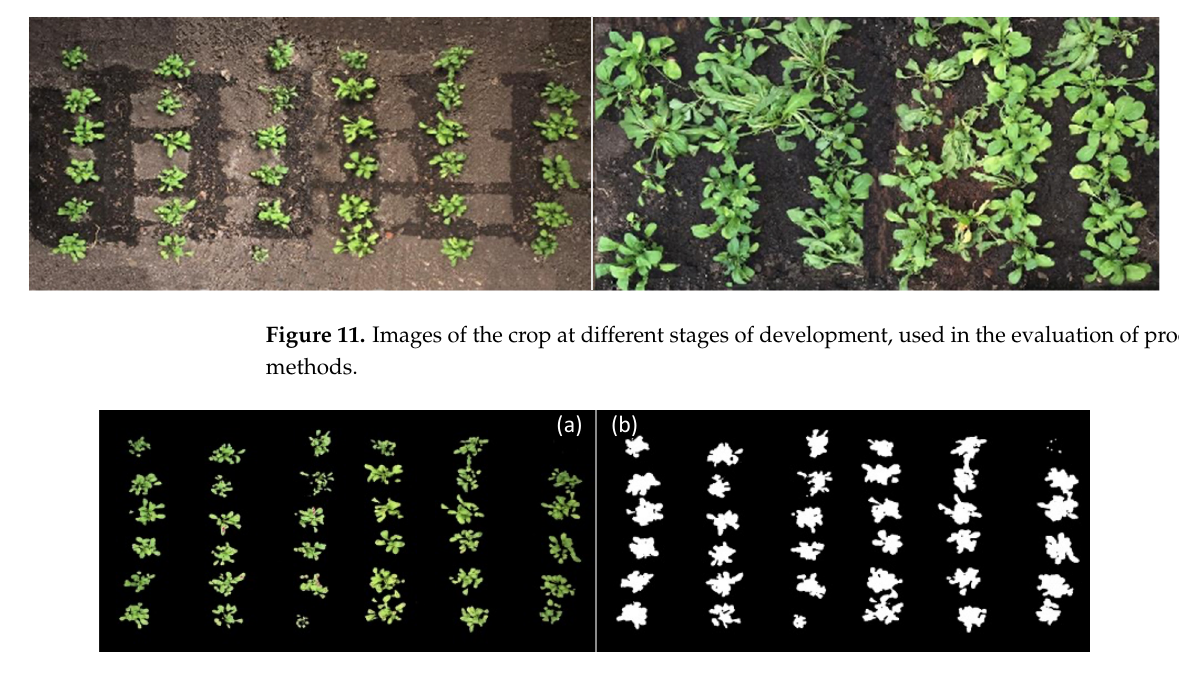
Figure 12. Images used as a reference for evaluating approaches, where ( a ) the pixels were segmented within the mean of the 10 selected pixels and ( b ) received a value equal to 1. Table 2. Descriptive statistics and ExG (RGB) evaluation metrics for image processing, where N represents the confidence level (95%).